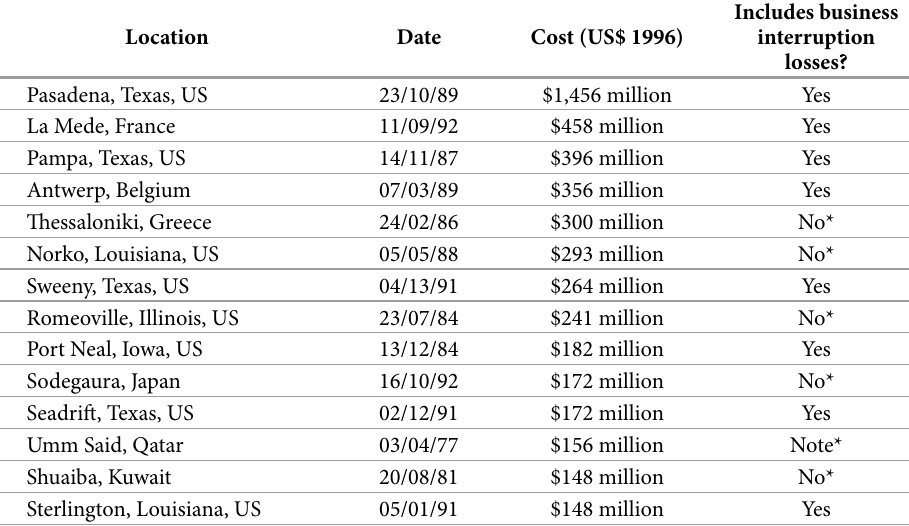
table 1. The cost of 14 accidents experienced world-wide in 1977–1992 (Fewtrell and Hirst 1998)